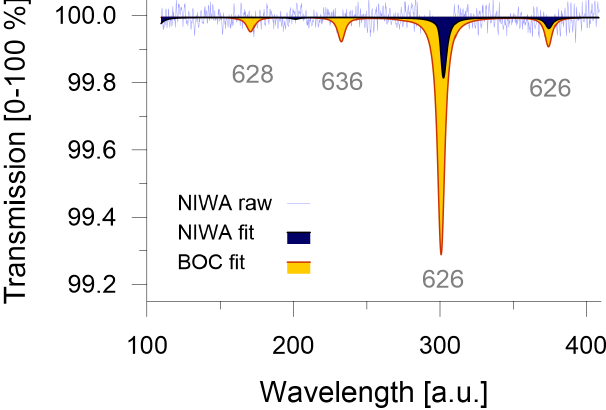
Figure 2. Size of CO 2 blank in CO 2 -free air and transmission (%) over artificial units (a.u.), provided by Delta Ray. Raw (light blue) and fitted (dark blue) data from CO 2 -free air made at NIWA in com- parison with fitted spectra of BOC’s ultra-zero-grade air